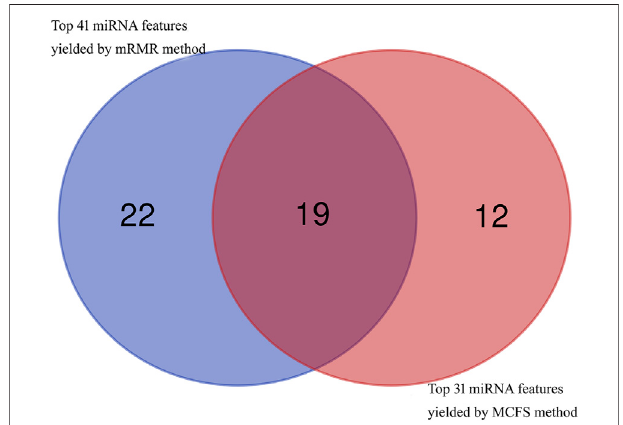
FIGURE 7 | Venn diagram to show top 41 miRNA features obtained by mRMR method and top 31 miRNA features obtained by MCFS method. Nineteen miRNA features are commonly identi fi